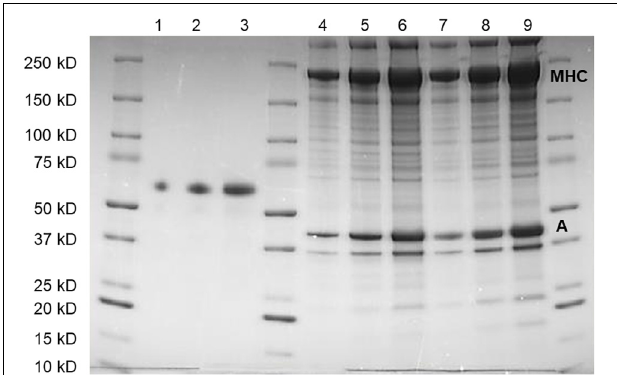
FIGURE 4 | SDS-poly acrylamide gel separation of protein extracts from normal (Lanes 4–6) and woody breast (Lanes 7–9) together with albumin standard (Lanes 1–3). Three different volumes of samples and amount of albumin were loaded on each gel. Myosin heavy chain (MHC) and actin (A) were identified on the basis on their apparent molecular